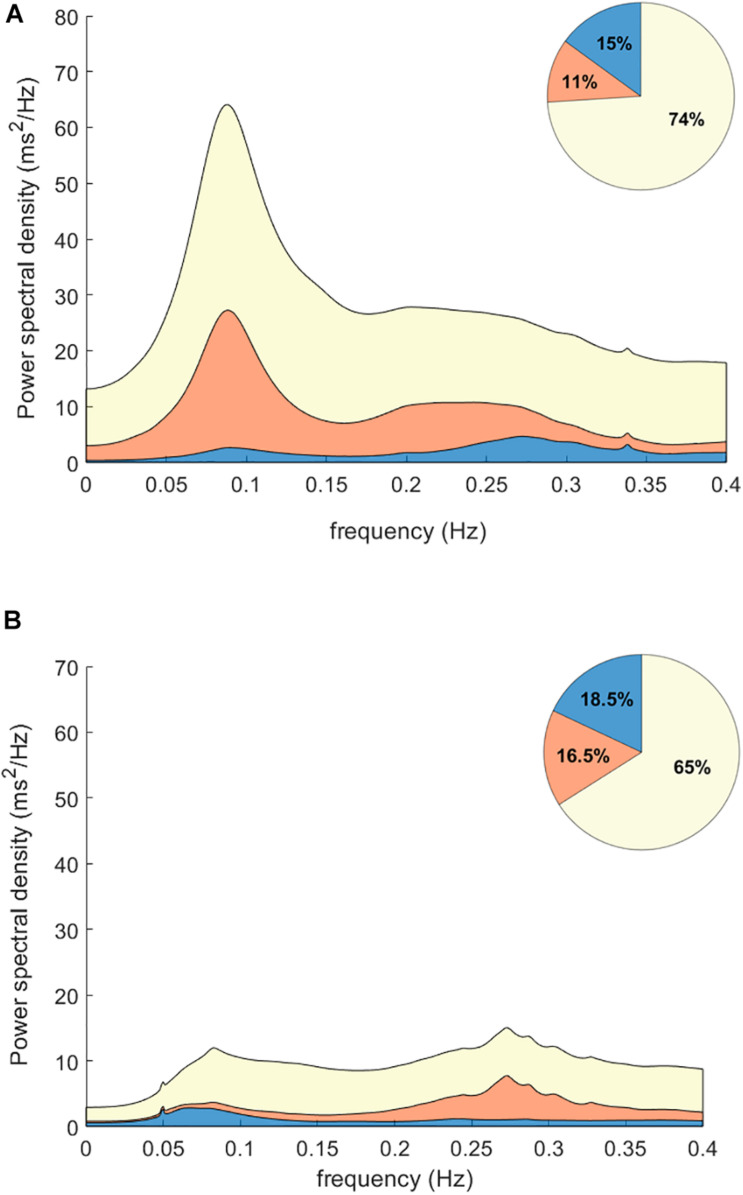
Power contributions to QT interval variability. Plots show the spectrograms averaged for non-survivors (A) and survivors (B) post MI. The relative contribution of RR interval variability is shown in blue; the contribution of respiration is shown in orange. While the absolute value of the RR (blue) and respiration (orange) contributions are higher for non-survivors due to the overall increase in QTV in that group, the relative contribution of RR and respiration to QT power is decreased in non-survivors as shown in the pie charts. Notably, the QT power independent of RR and respiration (yellow) is increased and exhibits a clear peak in the low-frequency band.